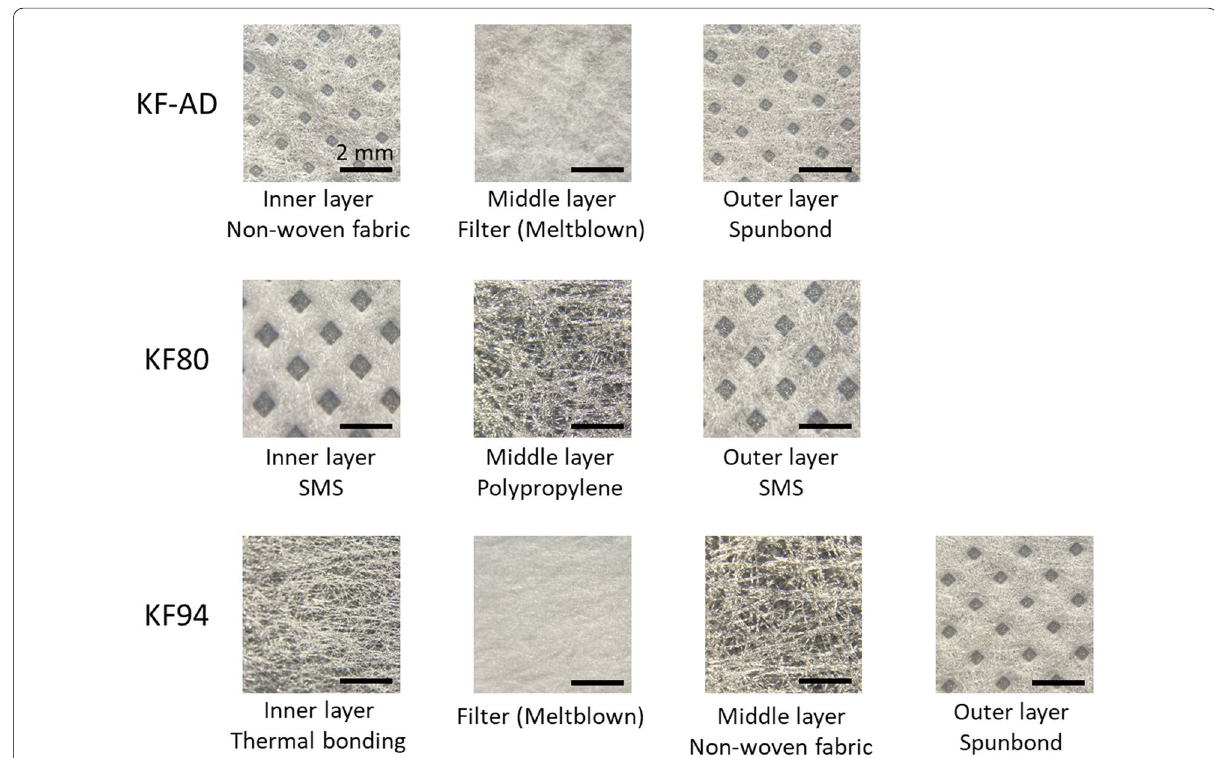
Fig. 2 Structure of mask layers of KF‑AD, KF80, and KF94 visualized through an optical